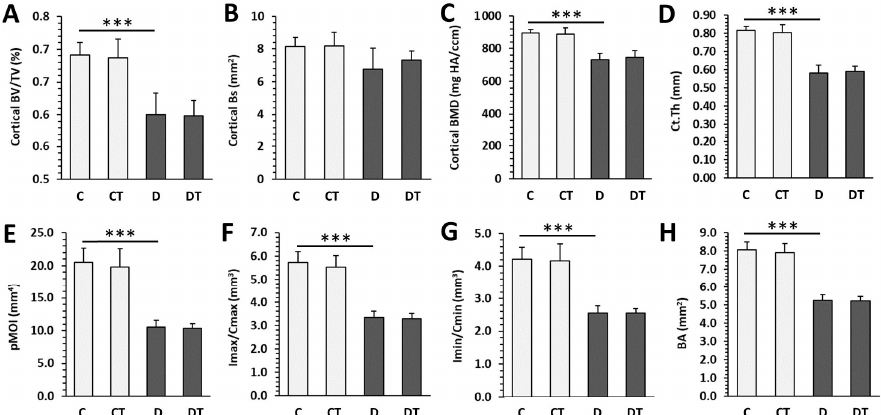
Figure 4. Micro-CT cortical parameters in non-diabetic rats (C), those treated with cemtirestat (CT), STZ-induced diabetic rats (D), and those treated with cemtirestat (DT). ( A ) Volume fraction (bone volume/total volume; BV/TV), ( B ) bone surface (Bs), ( C ) bone mineral density (BMD), ( D ) cortical bone thickness (Ct.Th), ( E ) polar moment of inertia (pMOI), ( F ) maximum loading resistance (Imax/Cmax), ( G ) minimum loading resistance (Imin/Cmin), and ( H ) bone area (BA). The values are represented as mean ± SD. Only differences between groups C and D, as well as C and CT, and D and DT are indicated (*** p < 0.001).